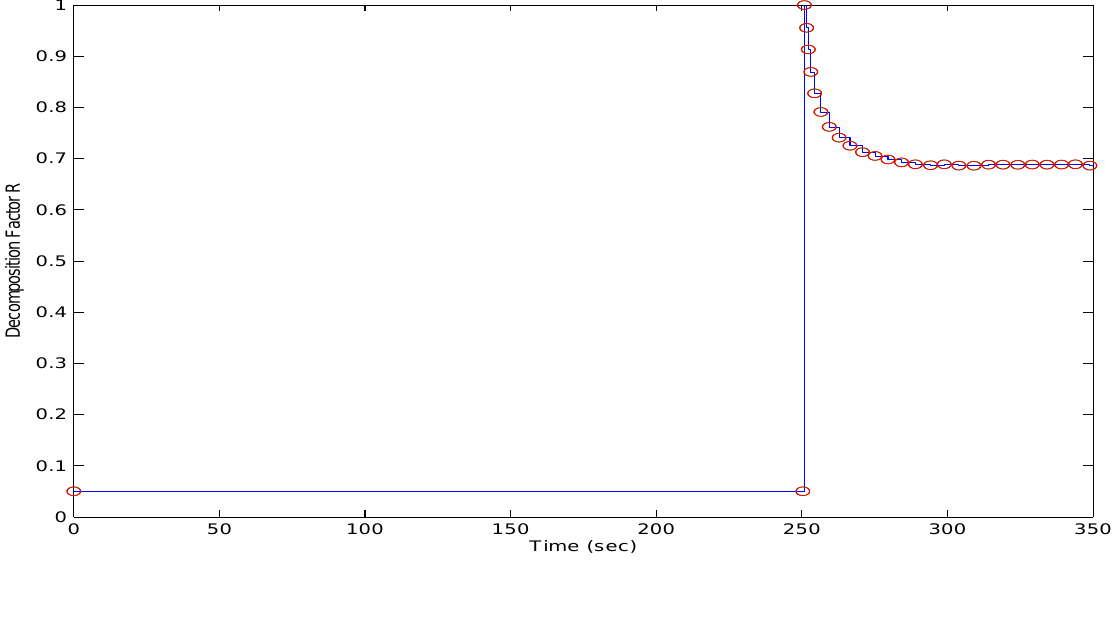
Figure 13 . Convergence Error over experimental time (Initial values R = 0 : 1 , T d = 5 s, and (cid:22) = 0 : 01